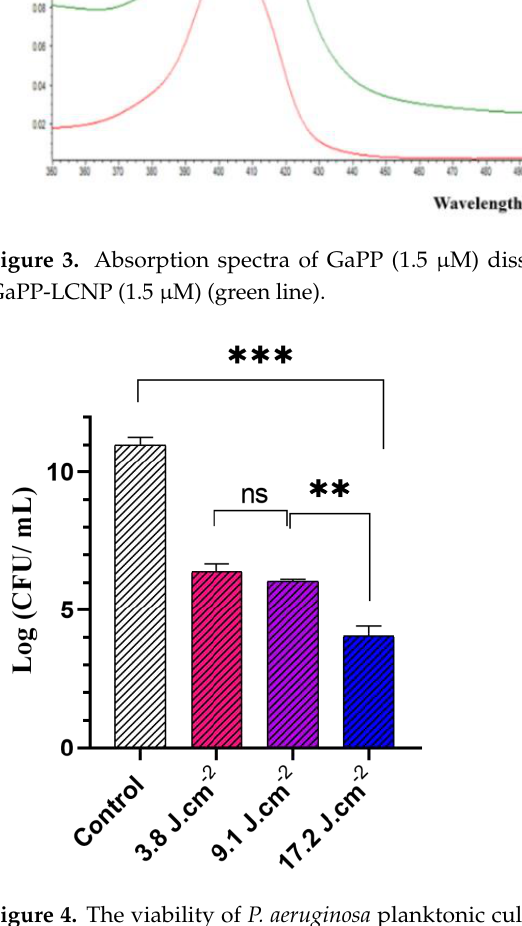
Figure 4. The viability of P. aeruginosa planktonic culture following treatment with different light doses of blue light at 405 nm ranging from (3.8 to 17.2) J.cm − 2 and GaPP-LCNP concentration doses of blue light at 405 nm ranging from (3.8 to 17.2) J.cm -2 and GaPP-LCNP concentration of 1.5 µM compared to negative control in the dark. Data presented as mean ± SD, n = 3. ns: non-signifi- cant, *** significant reduction in viability, P value < 0.0001, ** P value = 0.003 (one-way ANOVA test